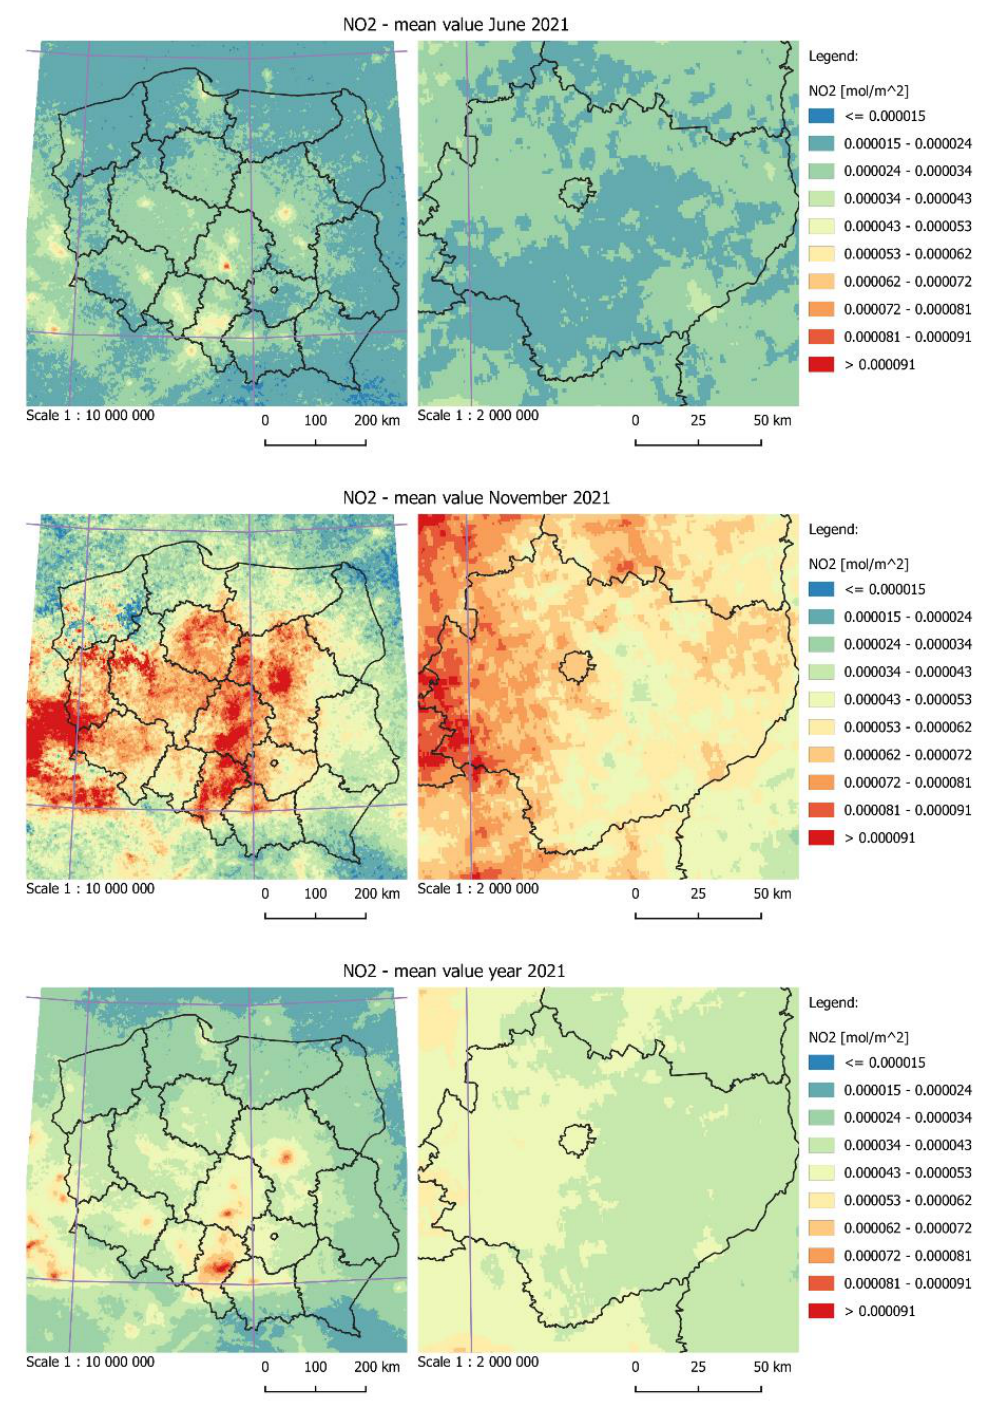
Figure 4. The average value of NO 2 concentration in June and November, and for the whole year 2021, calculated based on the data from the Copernicus Sentinel-5P satellite.